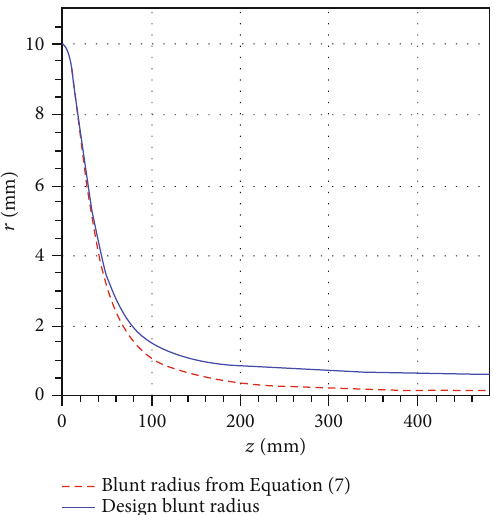
Figure 6: Variations of blunt radius alongside the spanwise